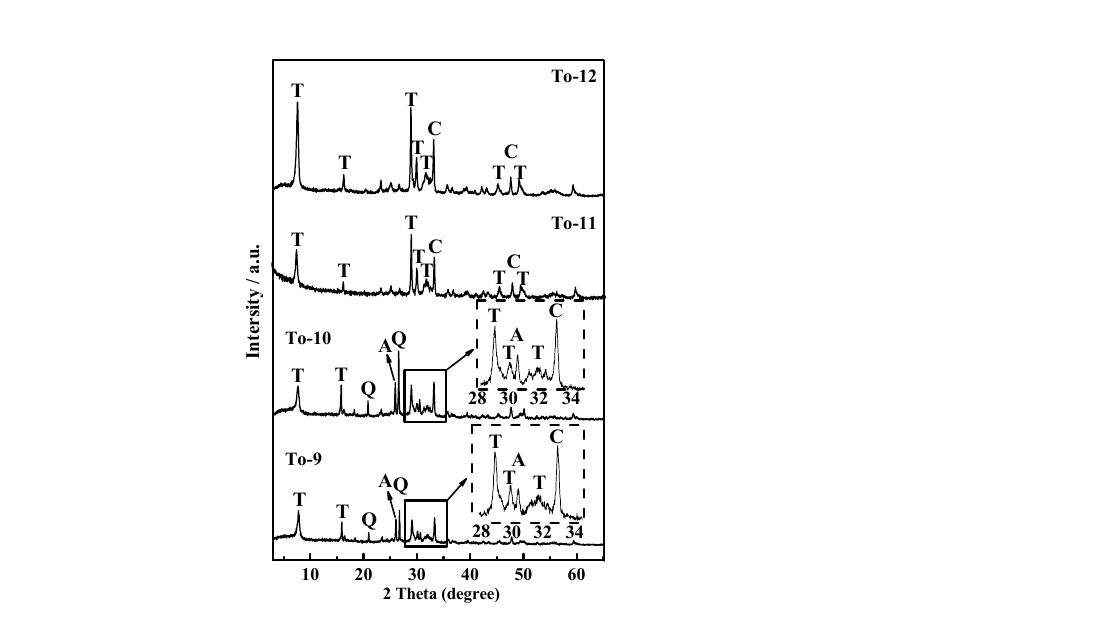
Figure 4. XRD patterns of products synthesized at different Ca/Si molar ratio at 200 °C for 12 h. T—11Å-TA; C—Ca 3 Al 2 O 6 ; A—Analcime; Q—Quartz.